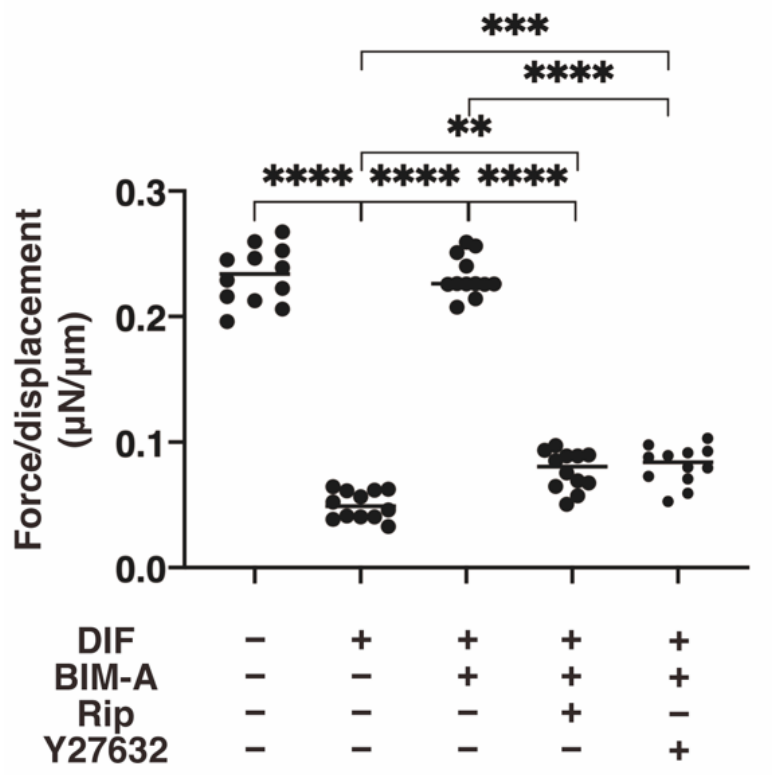
Figure 6. Additional effects of ROCK-i on BIM-A on physical stiffness during the adipogenesis of the 3T3-L1 3D spheroids. The 3D spheroids of 3T3-L1 cells were cultured under several conditions: preadipocytes of 3T3-L1 cells or their adipogenic differentiation (DIF) in the presence or absence of the combination of 100 nM BIM-A (BIM-A) and ROCK-i (10 μ M Ripasudil (Rip) or 10 μ M Y27632). The specimens collected on Day 7 were subjected to a physical solidity analysis. Among the above experimental conditions, the requiring force ( μ N) was measured and force/displacement ( μ N/ μ m) was potted (right panel). ** p < 0.01, *** p < 0.005, **** p < 0.001 (ANOVA followed by a Tukey’s